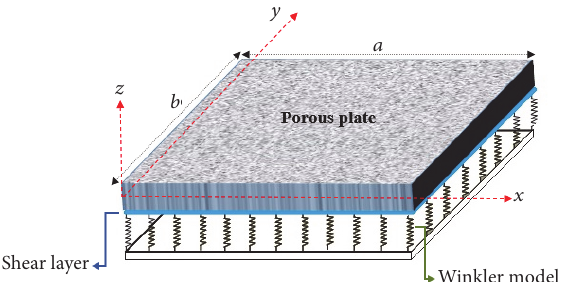
Figure 1: A schematic diagram of a porous